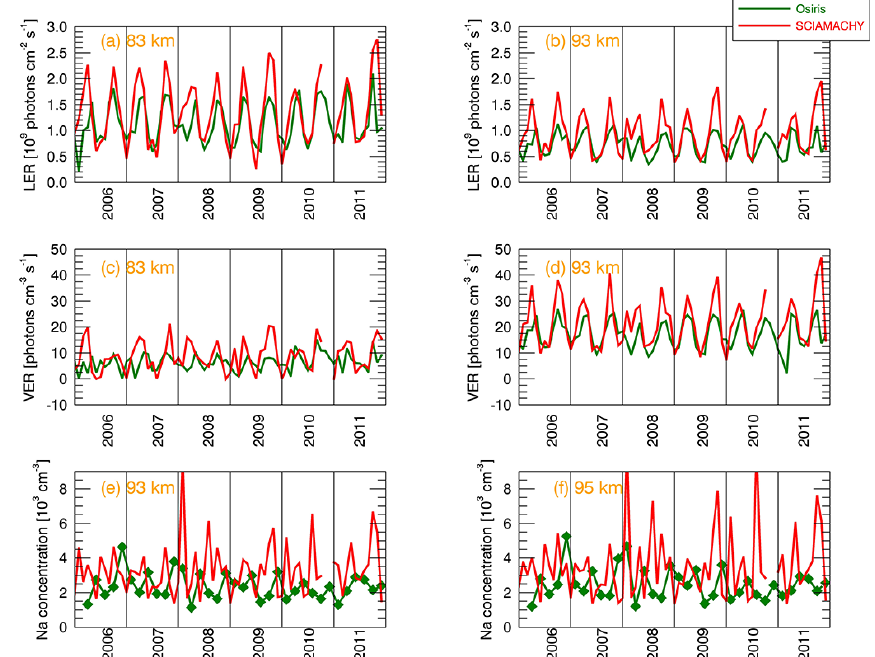
Figure 7. (a) LERs of OSIRIS and SCIAMACHY at 83km and (b) 93km tangent height; (c) VERs of OSIRIS and SCIAMACHY at 83km and (d) 93km altitude and (e) sodium concentrations of OSIRIS and SCIAMACHY at 93km and (f) 95km altitude. Because sodium concentrations from OSIRIS D-line nightglow measurements are only available every second month due two availability of SABER data and in order to help comparability between the two satellite measurements, we interpolated linearly between the available sodium concentrations. The actual results are marked with green diamonds, while the interpolated data points have no